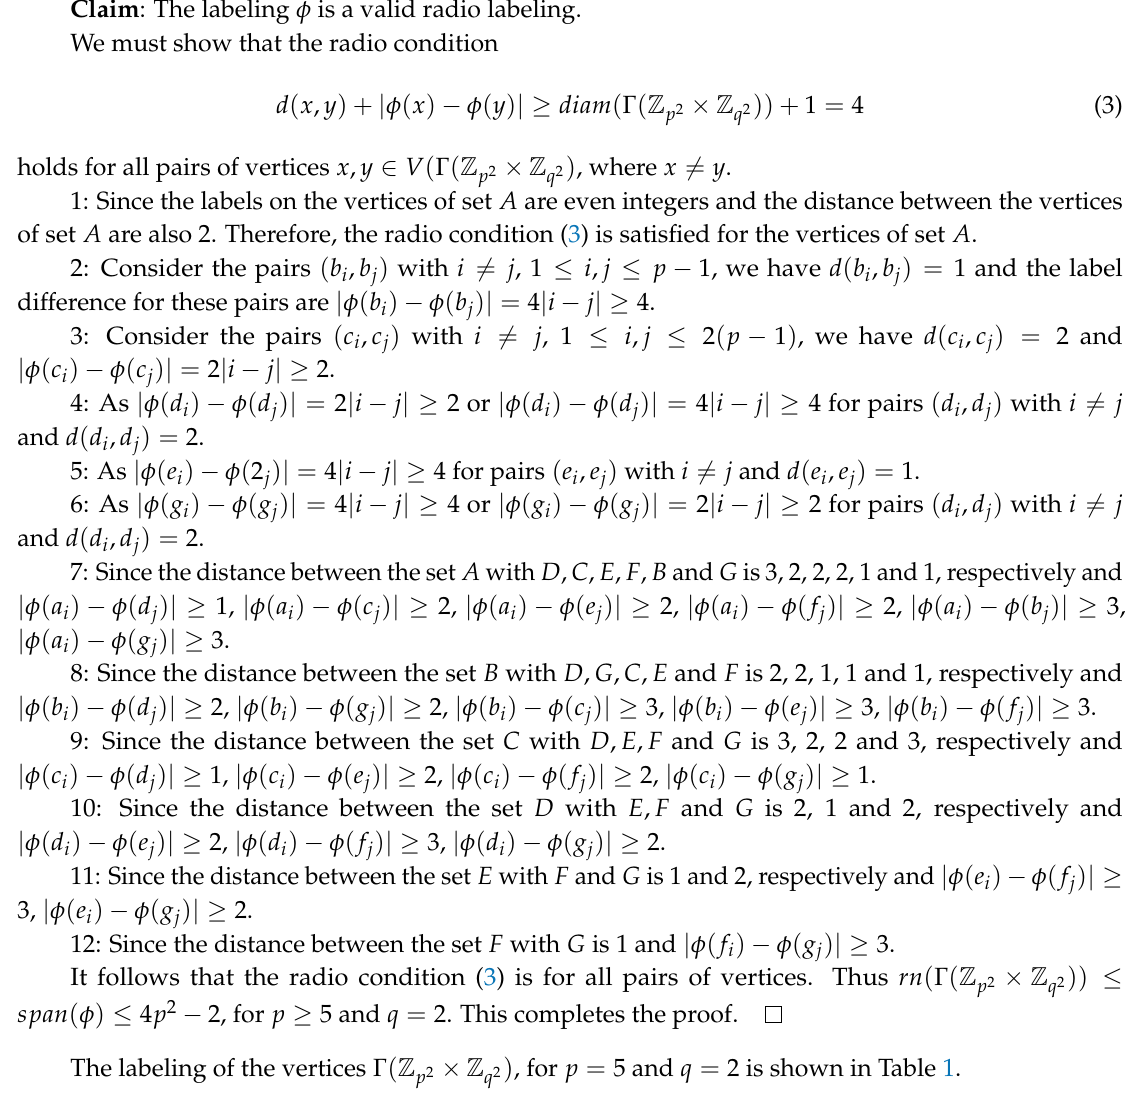
Table 1. The vertex labels of Γ ( Z p 2 × Z q 2 ) , for p = 5 and q = 2.